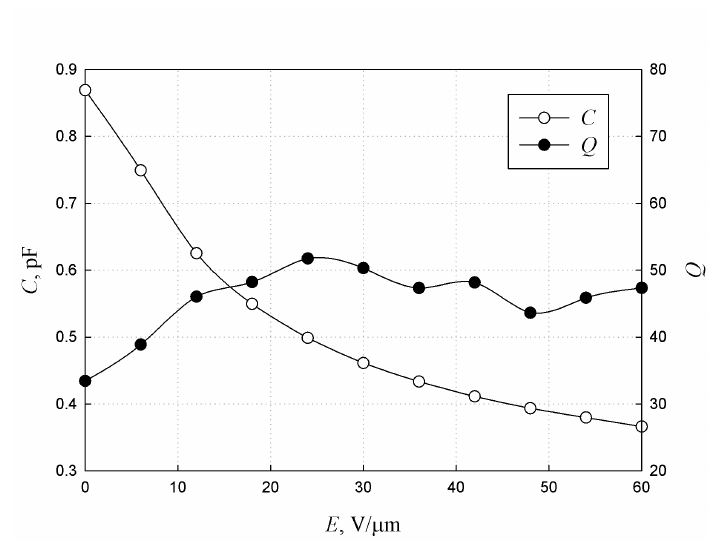
Figure 2. Small signal capacitance and Q-factor of BST film capacitor measured at f = 2 GHz versus dc field strength.